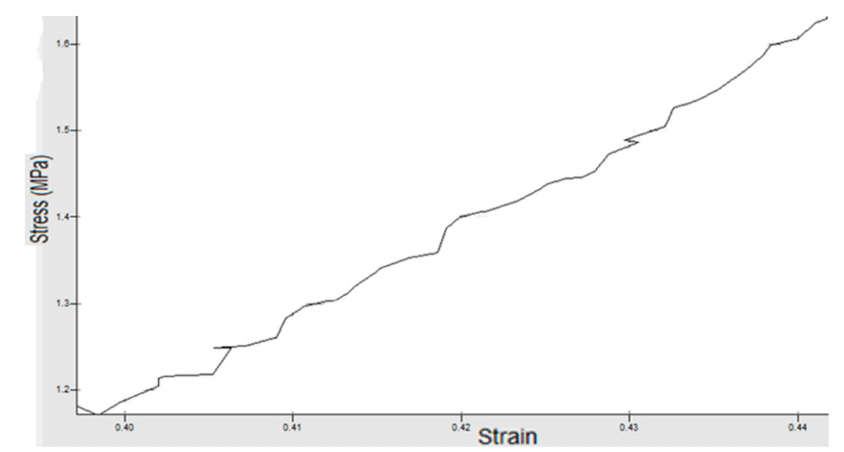
Figure 6. Piece 2 with speed v = 6 mm/s and force F = 500 N.